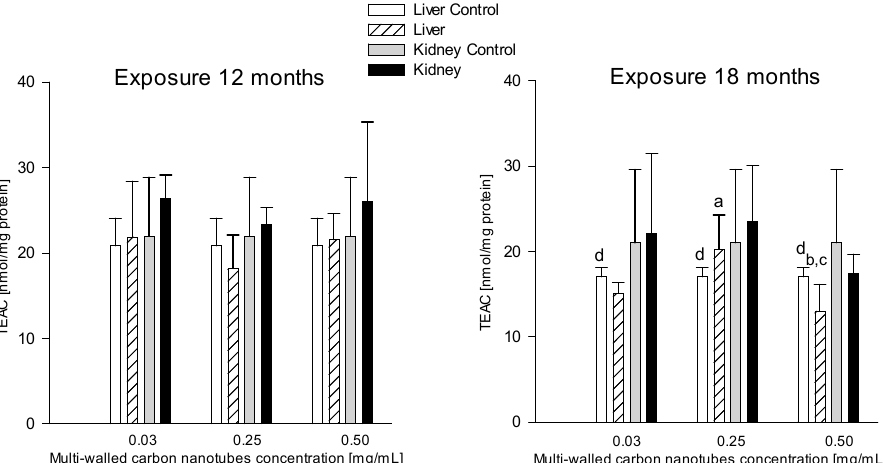
Figure 7. Comparison of Trolox equivalent antioxidant capacity (TEAC) concentrations in the liver and kidneys of animals exposed to multi-walled carbon nanotubes for 12 and 18 months. (a)—statistically significant difference for the group receiving MWCNTs in a concentration of 0.25 mg/mL versus 0.03 mg/mL in the livers ( p = 0.024330); (b)—statistically significant difference for the group receiving MWCNTs in a concentration of 0.5 mg/mL versus 0.25 mg/mL in the livers ( p = 0.001632); (c)—statistically significant difference for the group receiving MWCNTs in nanotube concentration of 0.5 mg/mL at 18 months versus 12 months in the livers ( p = 0.000702); (d)—statistically significant difference for control group at 18 months versus control at 12 months in the livers ( p = 0.037120). Additionally, in the group of rats given nanotubes at a concentration of 0.5 mg/mL, statistically significant differences were shown when compared to the rats exposed for 18 months to the concentration of 0.25 mg/mL (12.99 ± 3.11 and 20.13 ± 4.02 nmol/mg protein, respectively), TEAC levels in rats receiving nanotubes at a concentration of 0.5 mg/mL